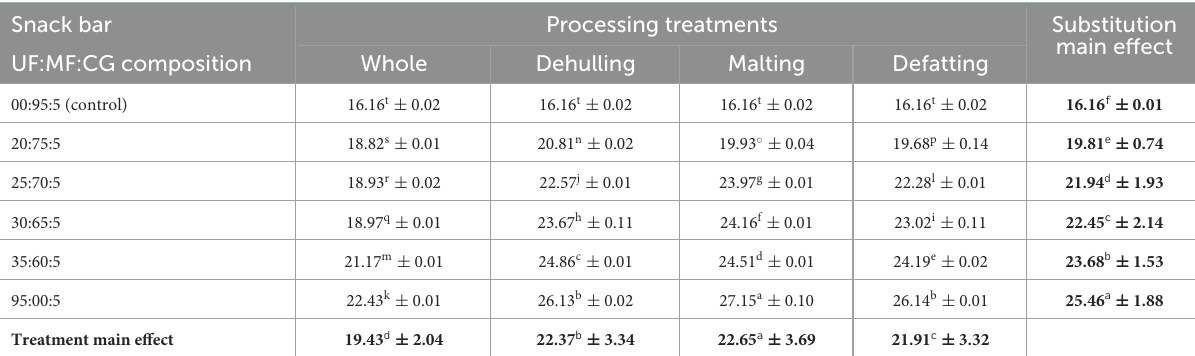
TABLE 3 Effect of processing and substituted levels of Ukwa flours on crude protein content (%) of maize–coconut snack bars. Snack bar Processing